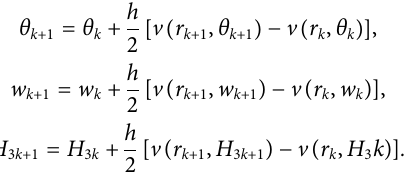
Frontiers in Physics |